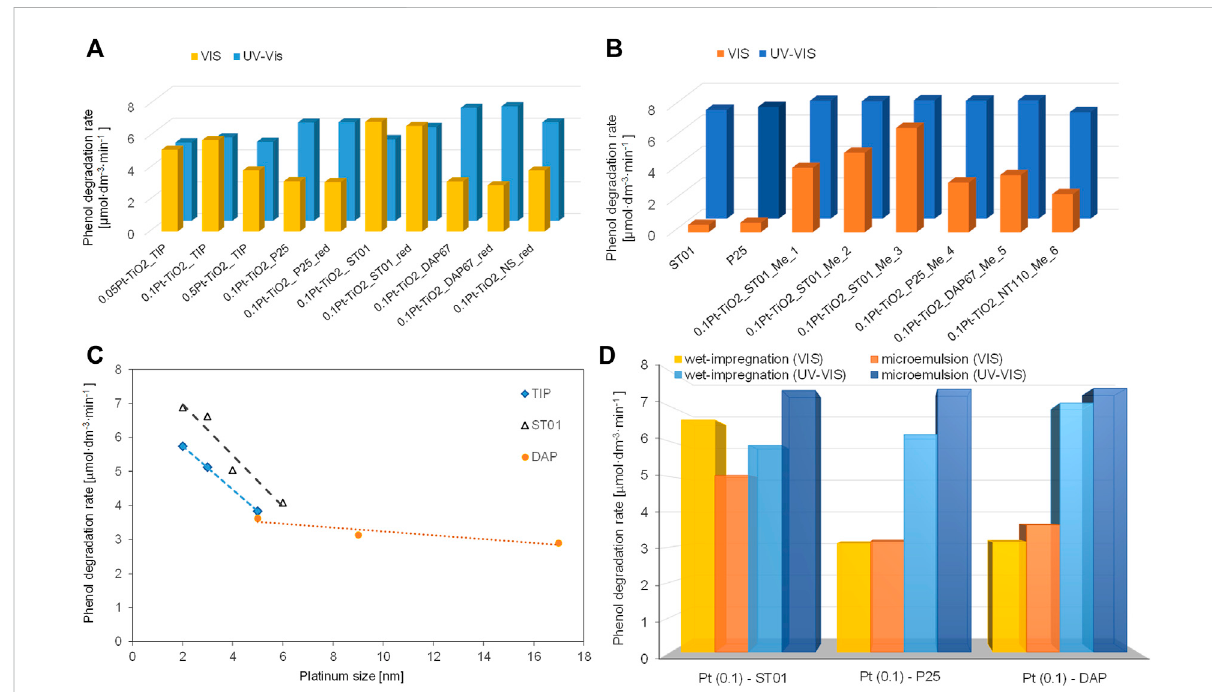
FIGURE 7 (A) wet-impregnation method, (B) microemulsion method; (C) Correlation (A,B) Photocatalytic activity of Pt-TiO 2 samples obtained by: between Pt NPs ’ size and photocatalytic activity of TIP (self-synthesized titania from titanium isopropoxide), ST01 (commercial samples of fi ne anatase) and DAP, (D) Comparison of UV-vis and visible-light photocatalytic activity for Pt-modi fi ed titania samples. Adapted from (Zielinska-Jurek et al., 2019), under Creative Common CC BY